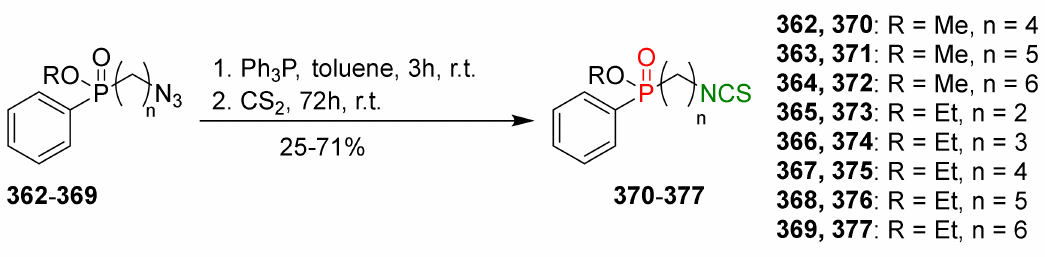
Figure 42. Synthesis of methyl and ethyl ( ω -isothiocyanatoalkyl)(phenyl)phosphinates 370 – 377